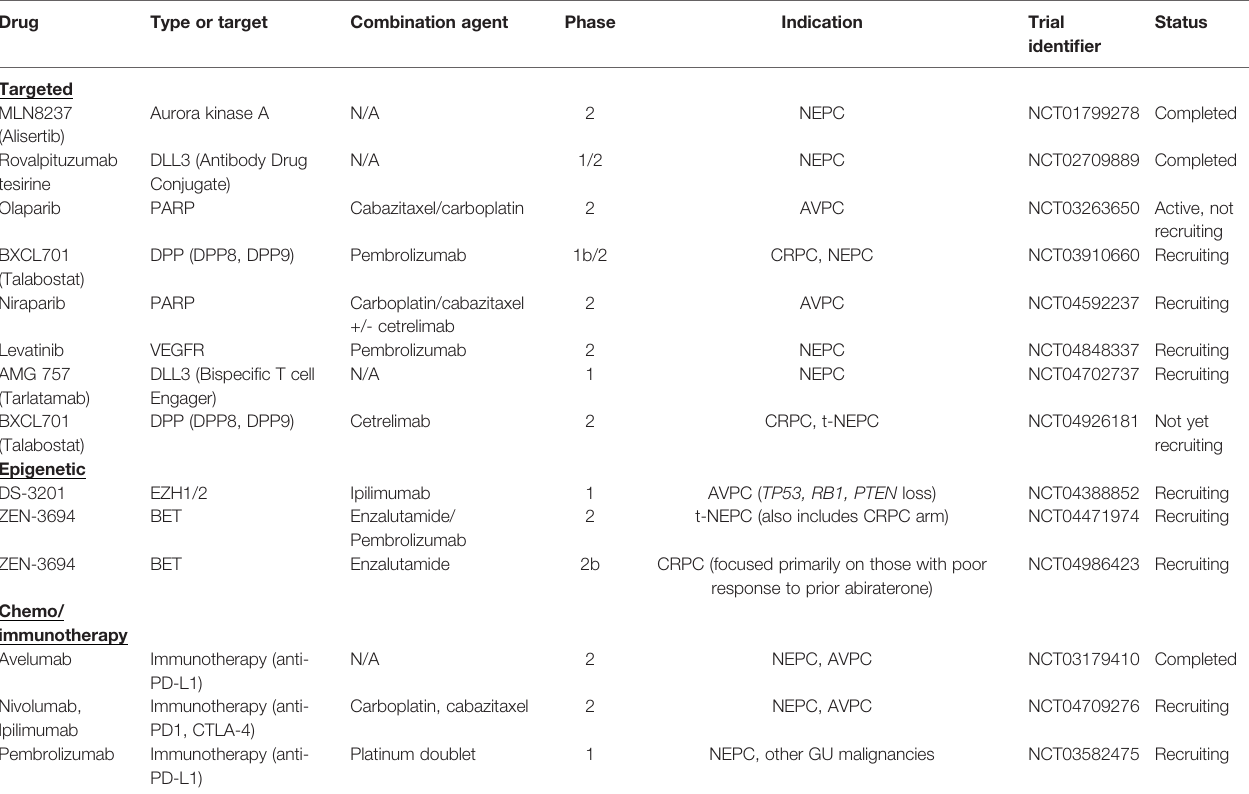
TABLE 1 | Recent clinical trials in neuroendocrine prostate